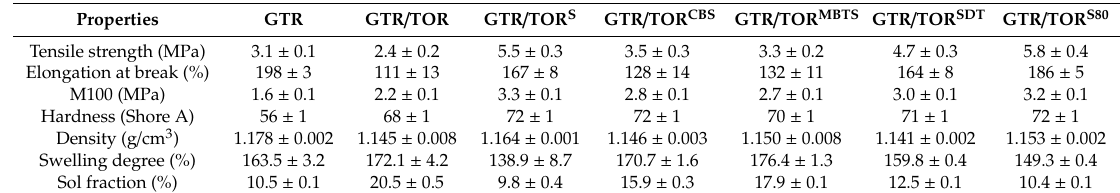
Table 4. Physico-mechanical properties of the studied samples.